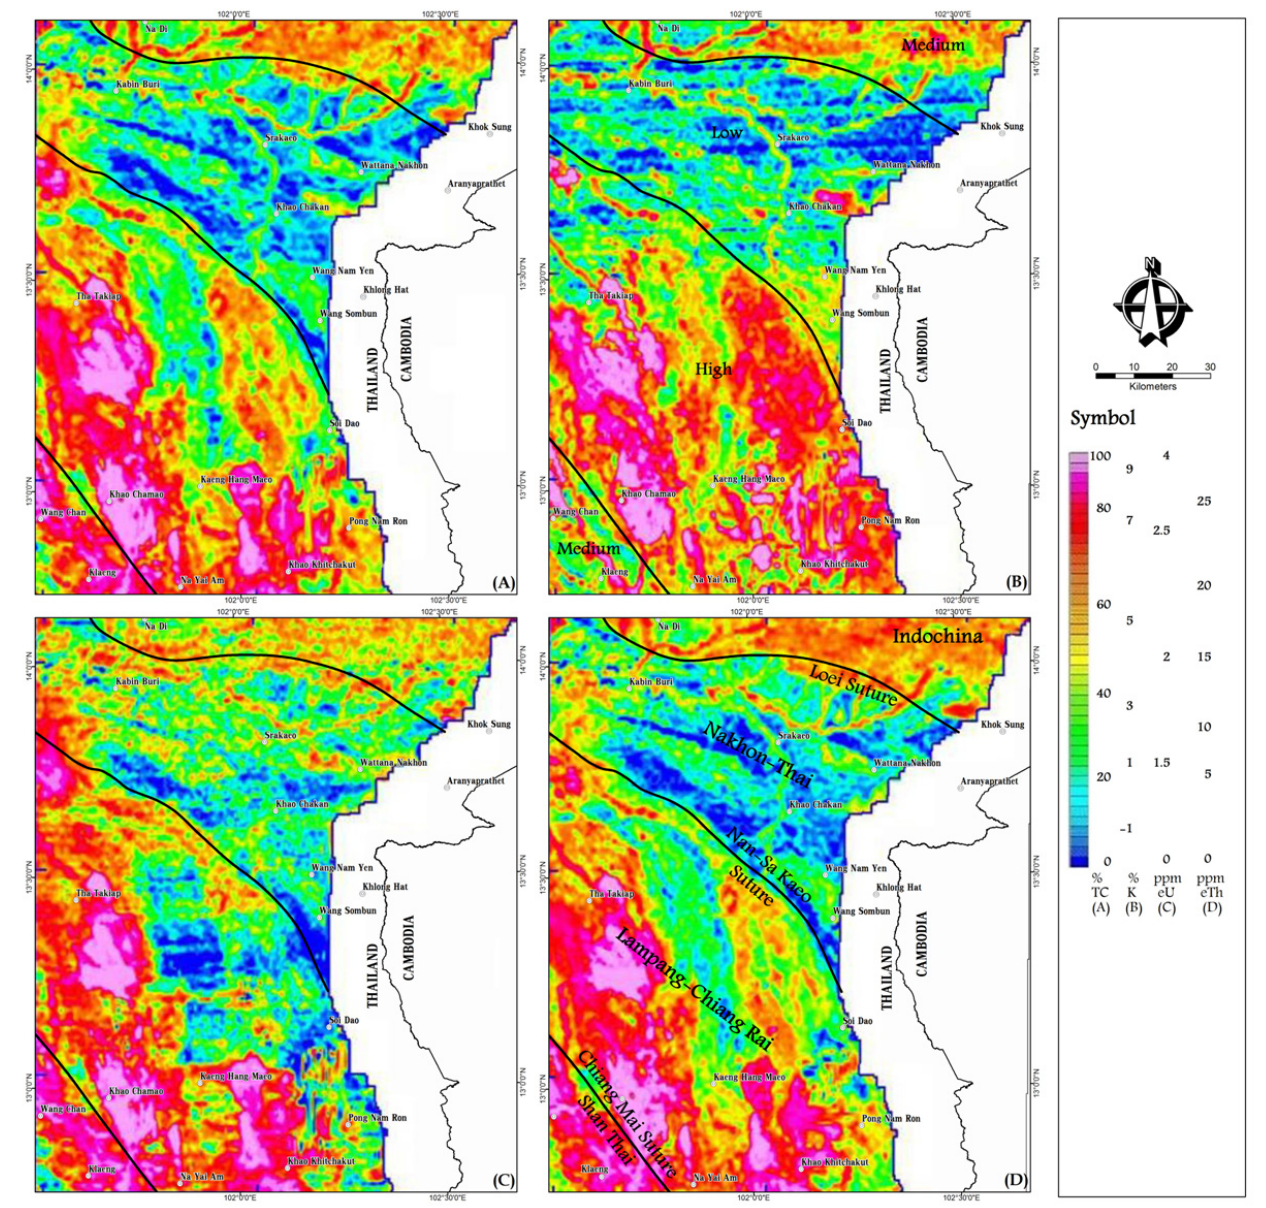
Figure 3. Enhanced radiometric maps of the study region in eastern Thailand showing the total counts of potassium, uranium and thorium contents (A, TC, in %), the potassium content (B, K, in %), the equivalent uranium contents (C, eU, in ppm), and the equivalent thorium contents (D, eTh, in